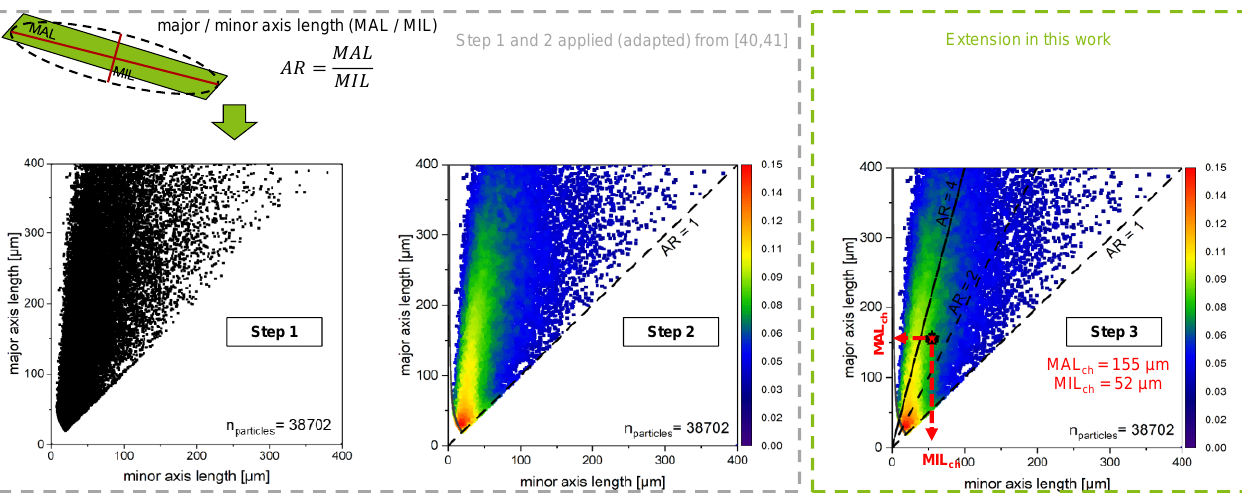
Figure 4. Three step process of the extended approach to analyze ALDs of non-spherical particles using needle-shaped L -alanine particles as an example. Step 1: Scatter plot of the measured MIL and MAL values of the sample with 38,702 particles. Step 2: Calculation of probability values with the function “density dots” of OriginPro 2021 for measured MIL and MAL. Step 3: Determination of the “center of mass” (red star), quantified by the coordinates of MAL ch and MIL ch at the corresponding axes, enabling comparability between ALDs.